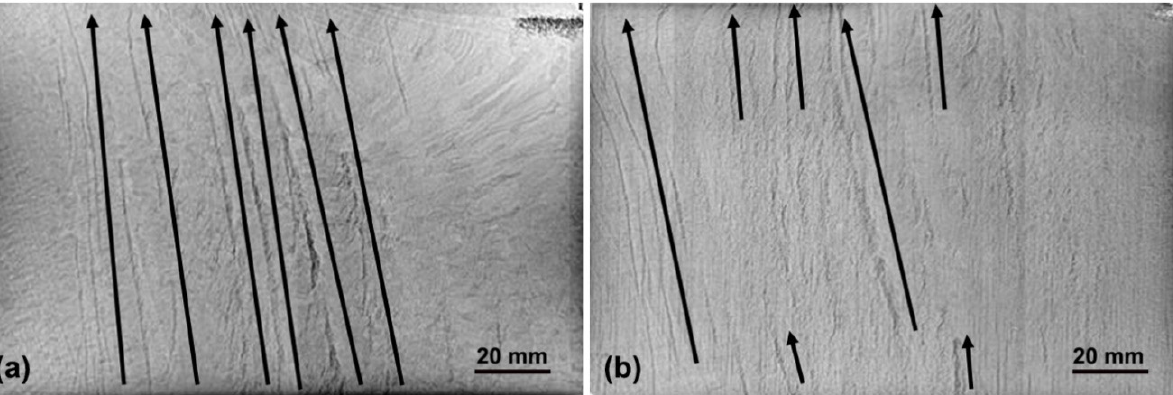
Figure 1. Macrostructure and channel segregation distributions in the top slice of Air- ( a ) and He-cooled ( b ) ingots of NbTi alloy. Channel segregation (CS) is marked by the black arrow.